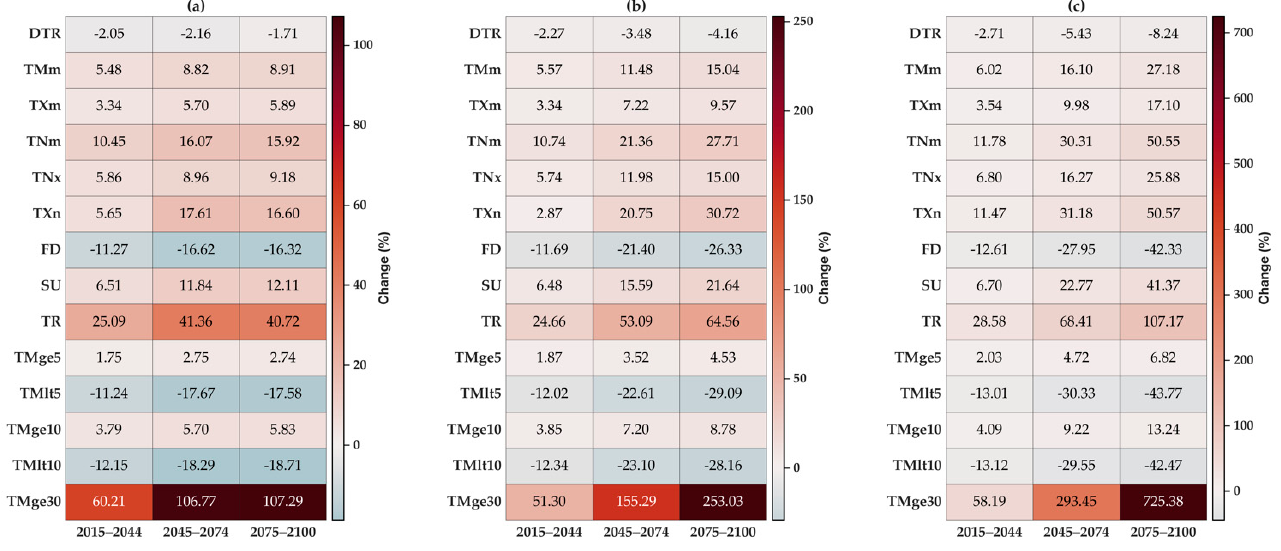
Figure 5. Projected changes in temperature extremes under ( a ) SSP1-2.6 ( b ) SSP2-4.5 and ( c ) SSP5- 8.5 in three different future scenarios over GRB.